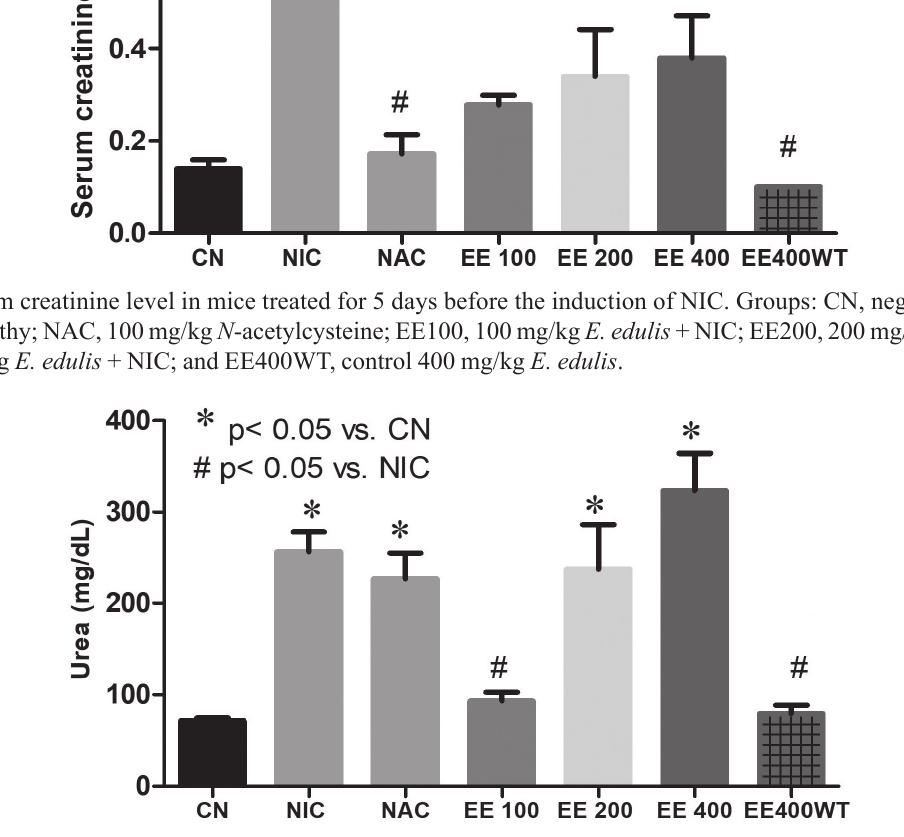
FIGURE 2 - Serum urea level in mice treated for 5 days before the induction of NIC. Groups: CN, negative control; NIC, contrast nephropathy; NAC, 100 mg/kg N -acetylcysteine; EE100, 100 mg/kg E. edulis + NIC; EE200, 200 mg/kg E. edulis + NIC; EE400, 400 mg/kg E. edulis + NIC; and EE400WT, control 400 mg/kg E. edulis